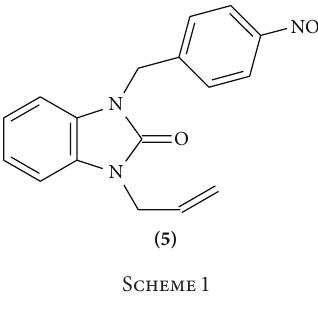
Figure 1 for the ORTEP representation of 5